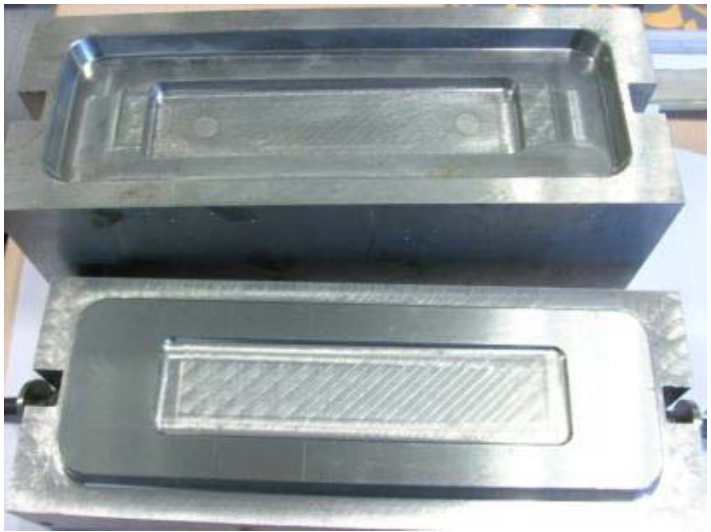
Figure 3. Metallic die to produce Aluminium foams with Alulight.